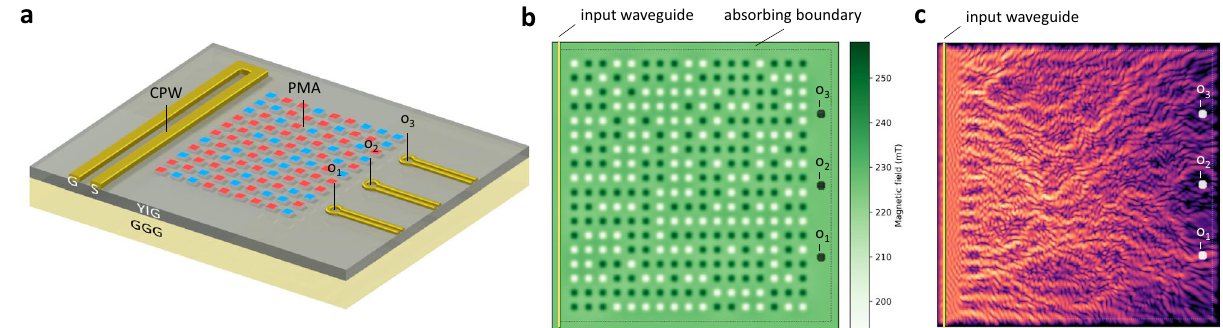
Fig. 1 Nanomagnet-based spin-wave scatterer. a The schematics of the envisioned computing device. The input signal is applied on the coplanar waveguide (CPW) on the left and the magnetic state (up/down) of programming magnets on top of the YIG fi lm de fi ne the weights. b Magnets exhibiting perpendicular magnetic anisotropy are placed on top of the YIG fi lm and generate a bias- fi eld landscape. The training algorithm fi nds the binary state of the programming magnets. c Spin-wave intensity pattern for a particular applied input, which results in a high intensity at o 1 . The size of the simulation area is 10 μ m × 10